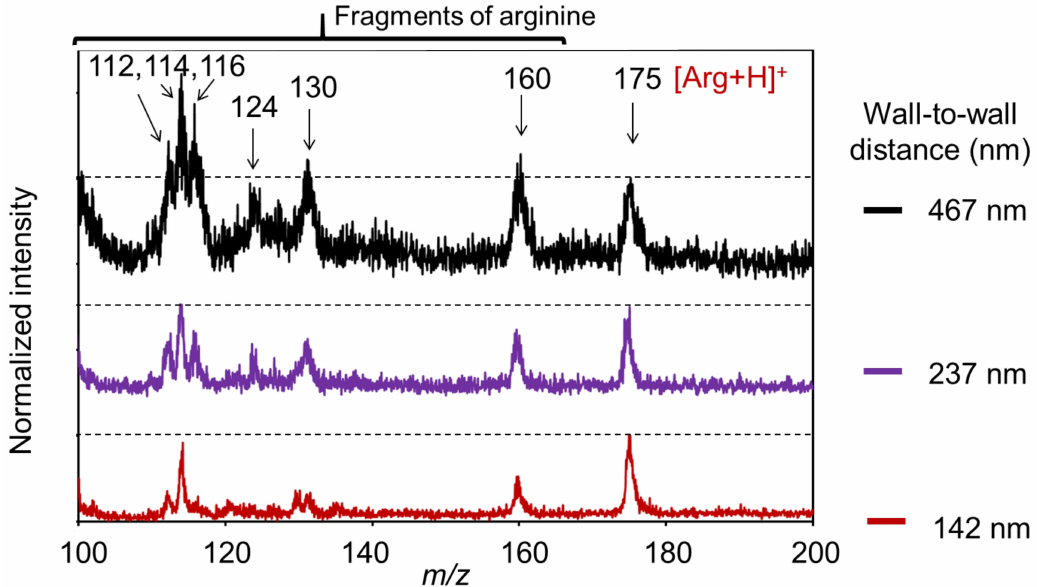
Figure 7. SALDI mass spectra of arginine using CNWs substrates with different wall-to-wall distances (normalized with respect to the intensity of [Arg+H] + at m / z =